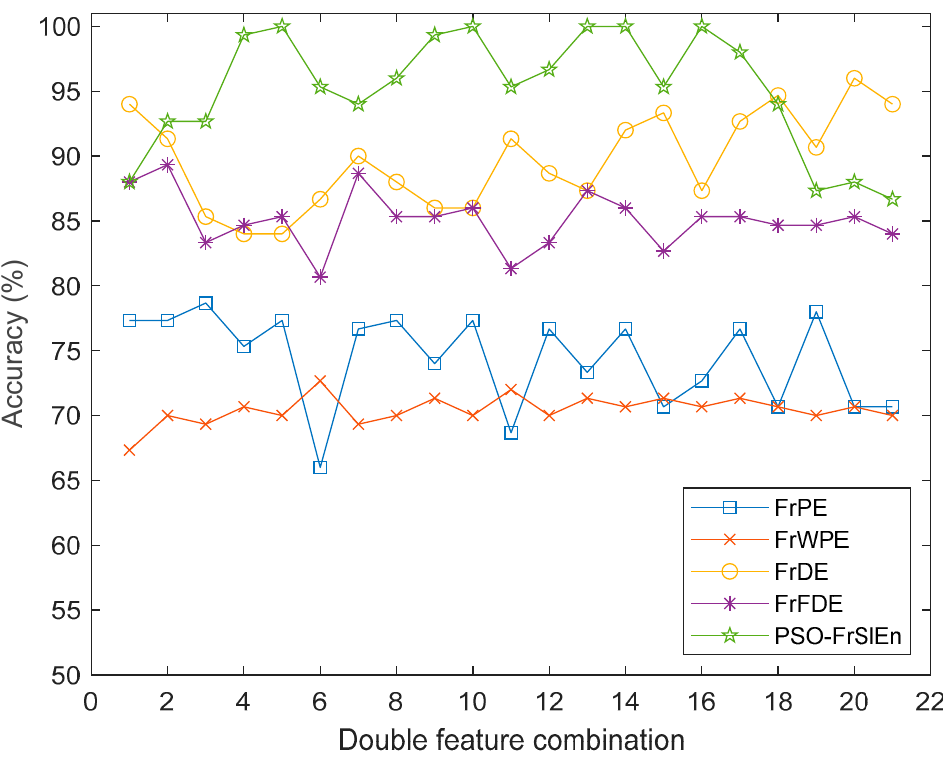
Figure 9. The classification accuracies under different double feature combinations.